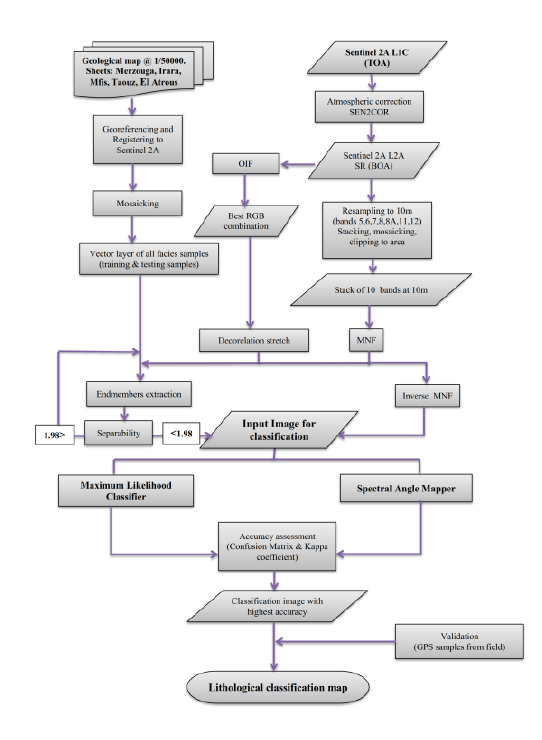
Figure 2: Flowchart of the methodology